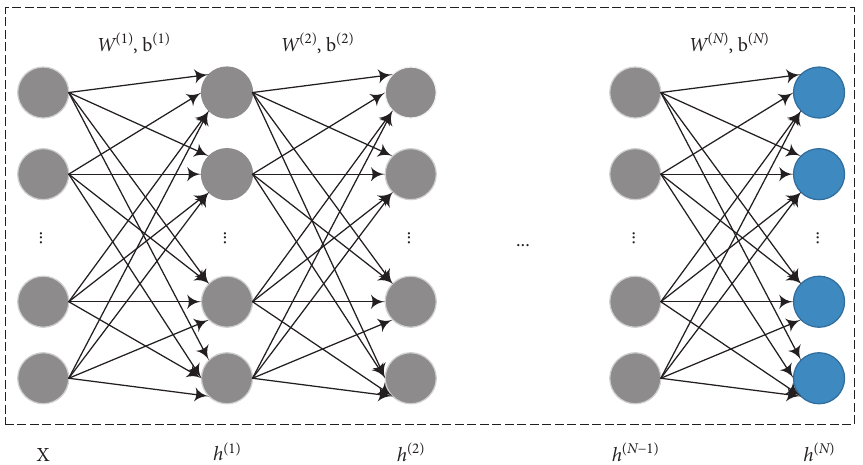
Figure 2: The network architecture. X is the input data sample of the network, ( h ( 1 ) ... h ( N − 1 ) ) are the output of the hidden layers, and h ( N ) is the output of the top layer. W ( N ) and b ( N ) are the parameters of the network to be learned, 1 ≤ n ≤ N